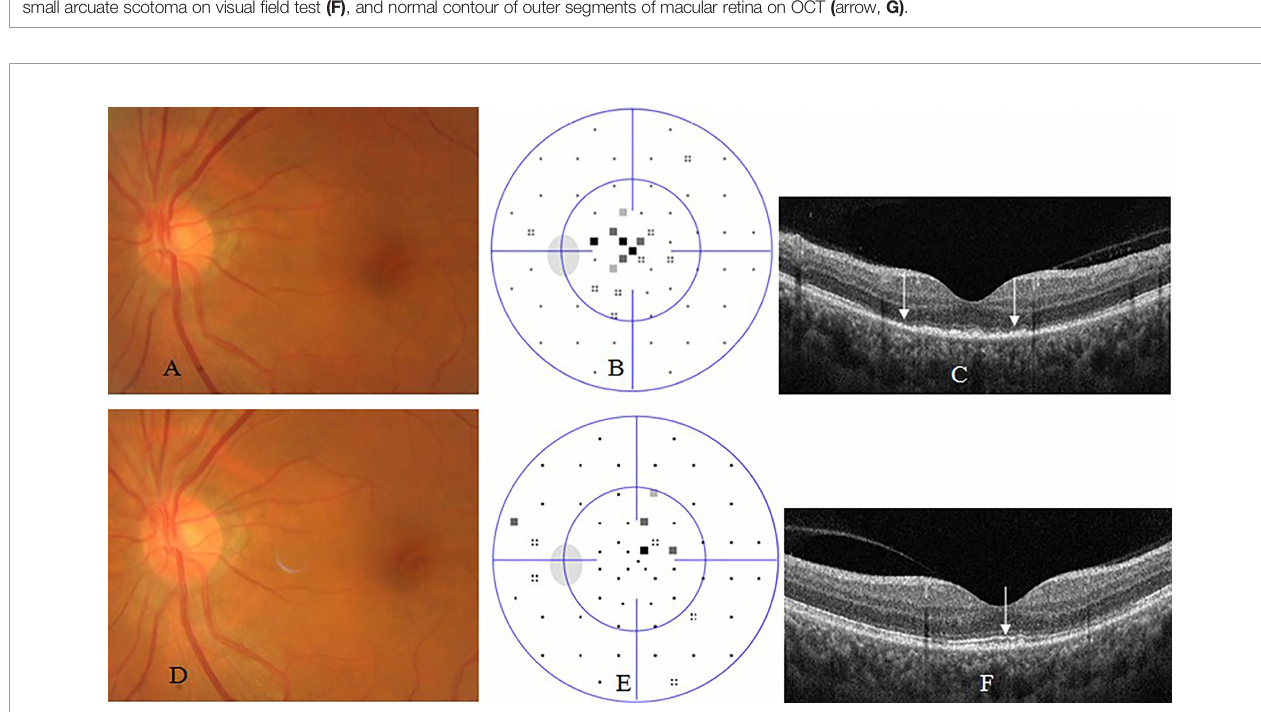
FIGURE 3 | Acute occult outer retinopathy -like syphilic retinitis. A 54-year old woman complained of blurred vision in the left eye for 2 weeks. At presentation, his left eye had visual acuity of 20/40, clear anterior segment and normal fundus (A) , small central scotoma on visual fi eld test (B) , and disruption or loss of outer segments of macular retina ( arrow, C) on OCT. Two months after antibiotic therapy, her visual acuity recovered to 20/20 in the left eye, with normal fundus (D) , nearly normal visual fi eld test (E) , and nearly complete recovery of outer segments of macular retina ( arrow, F)